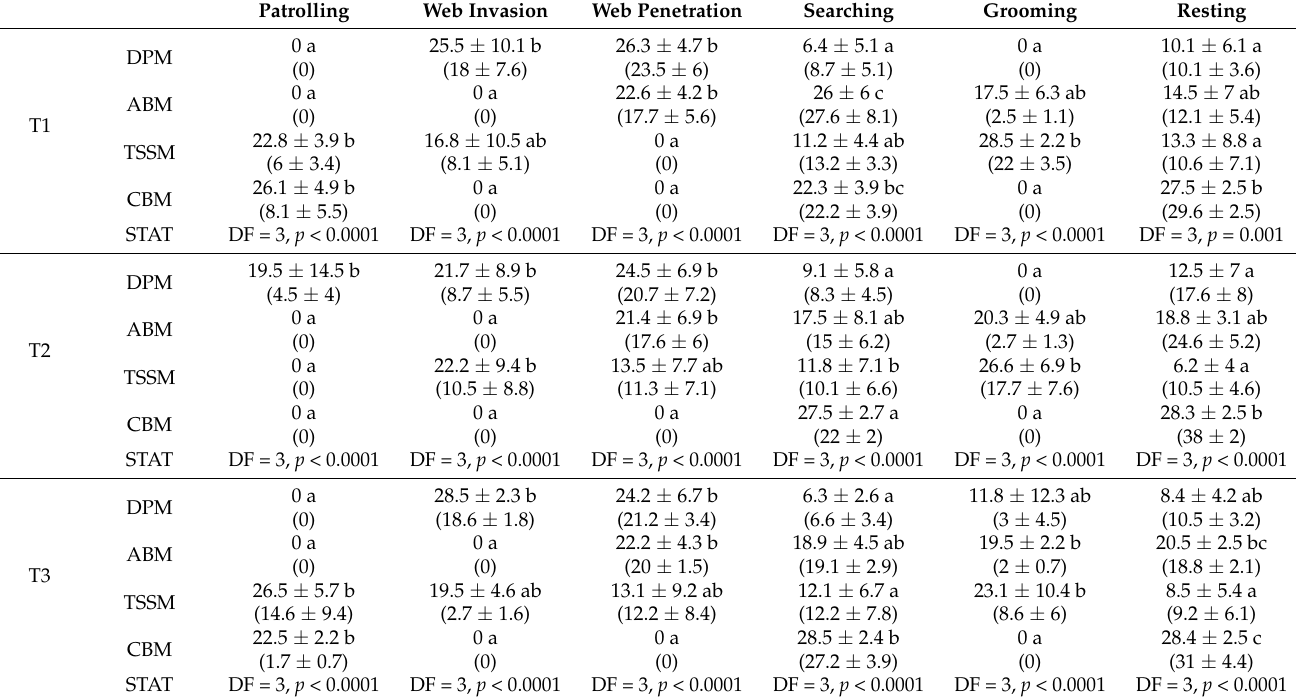
icance level: 0.0053. Means in each column with the same letters are non ‐ significantly different.